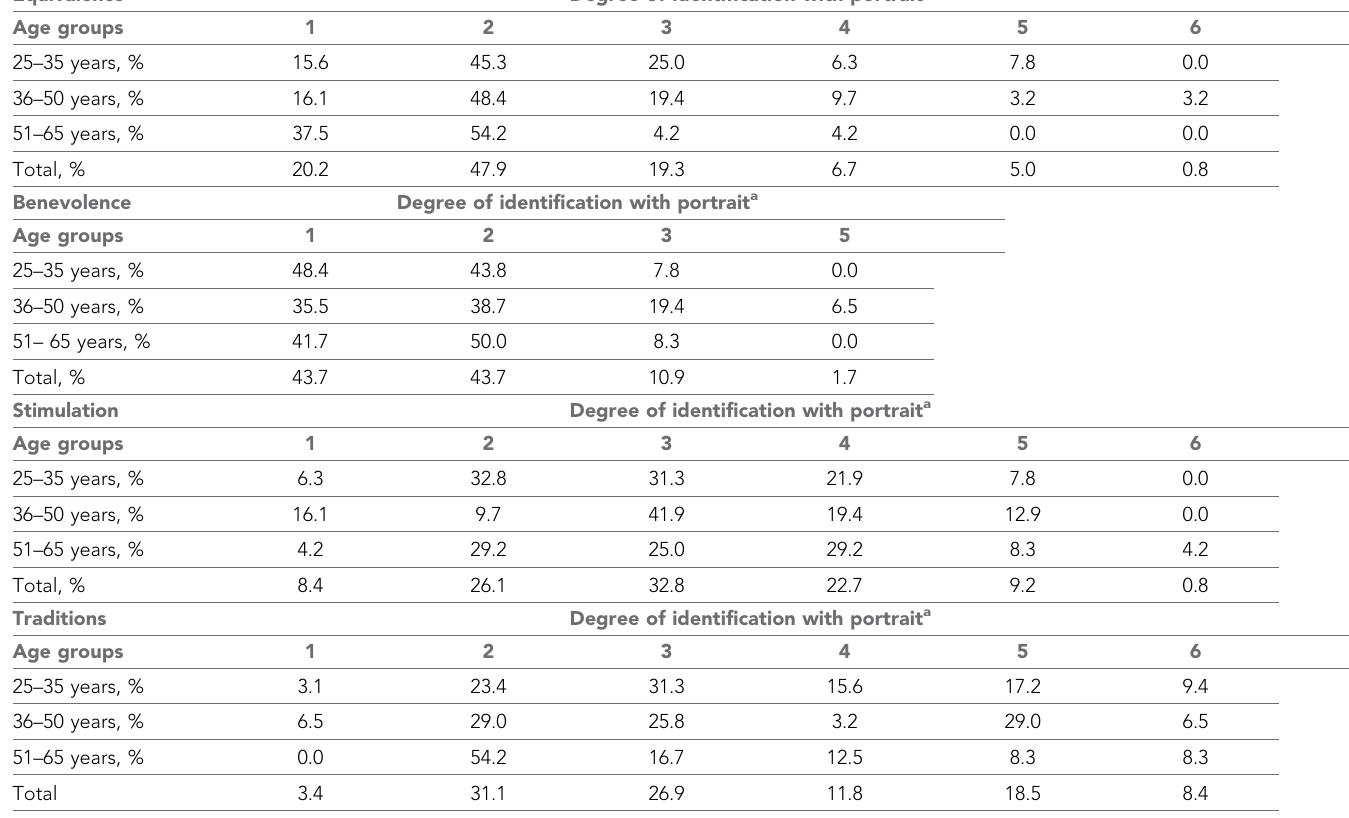
Table 3. Degree of identification with portraits of equivalence, benevolence, stimulation, and traditions, respectively, by age group Equivalence Degree of identification with portrait a